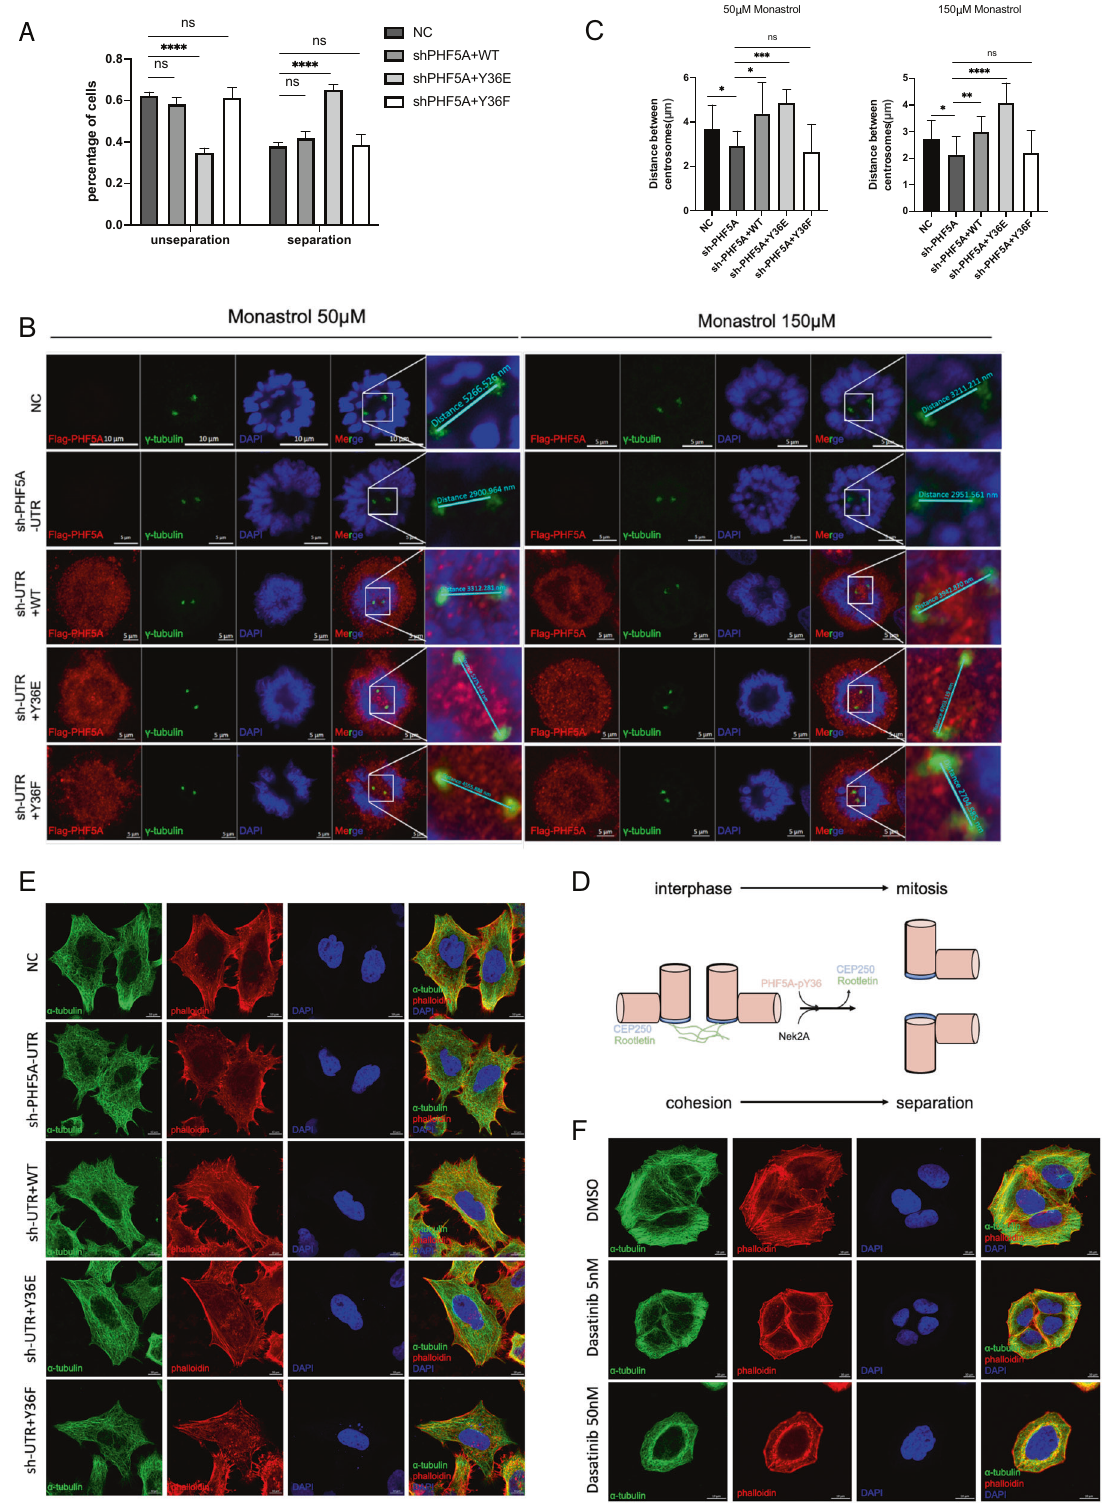
Fig. 5 pY36-PHF5A locates in the centrosome to promote centrosome separation and microtubule organization. A HeLa cells were infected with sh-PHF5A-UTR lentivirus and recued with PHF5A (wild-type, Y36E and Y36F). Inter-centrosome distances were measured from cells in interphase ( n = 30). B , C Sh-PHF5A and sh-rescued HeLa cells were synchronized with thymidine block and released to enrich cells in the G2 phase ( n = 20). Monastrol treatment inhibited Eg5-dependent centrosome splitting. Immunostaining was performed ( B ) and analyzed ( C ) to show the inter-centrosome distances. D Model for PHF5A promoting centrosome separation. E , F Sh-PHF5A, sh-rescued ( E ) or dasatinib treated ( F ) HeLa cells were labeled of microtubule or F-actin with anti- α -tubulin antibody or phalloidin. Immunostaining was performed to show the organization of the cytoskeleton.